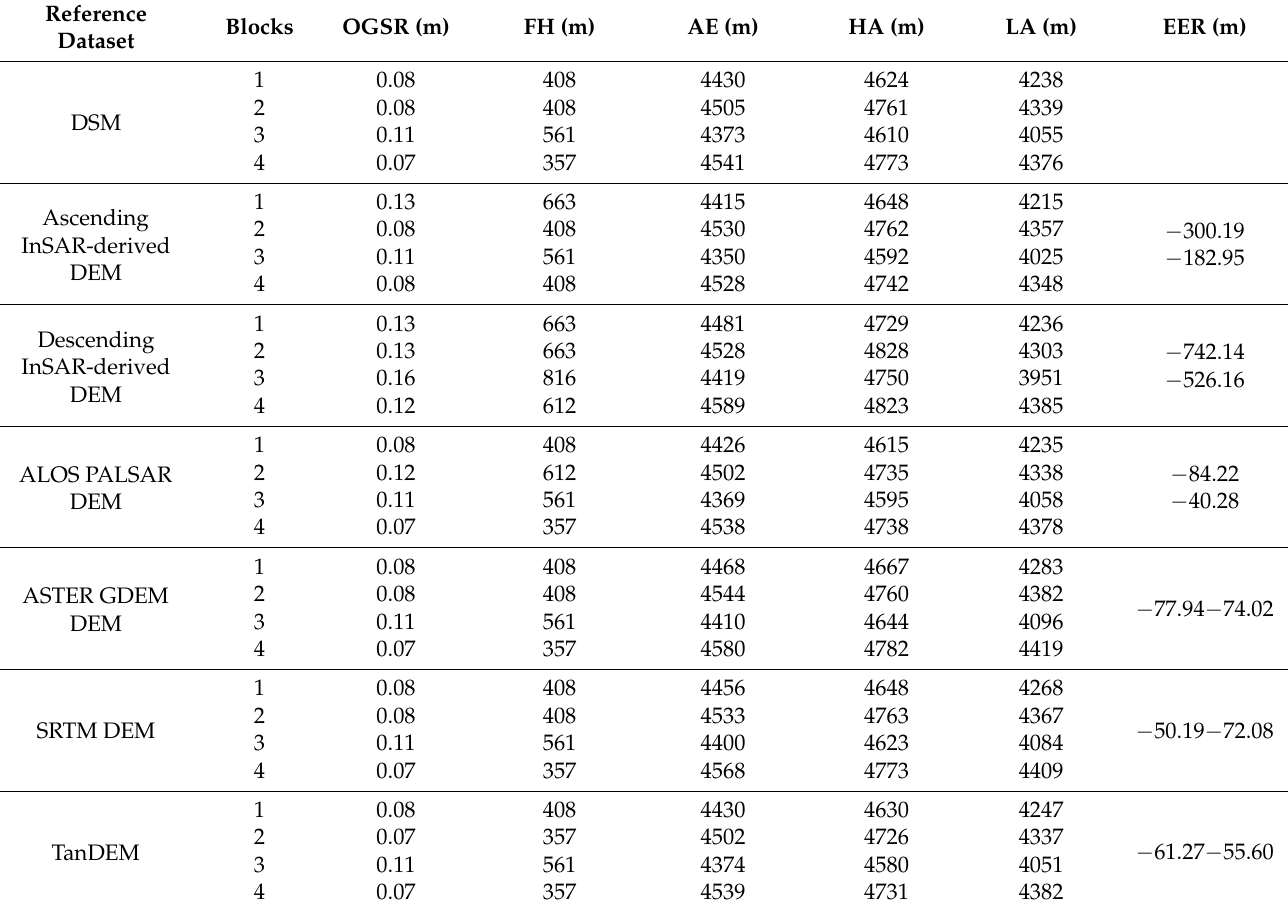
Table 3. Route planning results of the statistical parameters based on the different reference